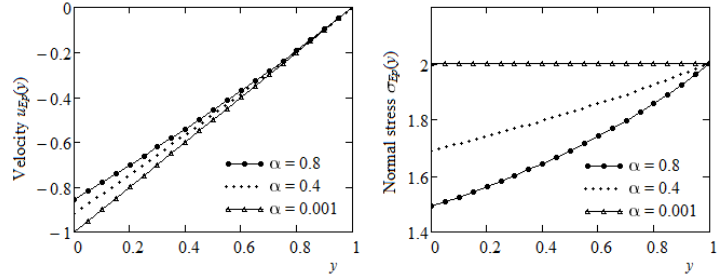
Figure 10. Profiles of u Ep ( y ) and σ Ep ( y ) for We = 1 and decreasing values of the pressure-viscosity coefficient α